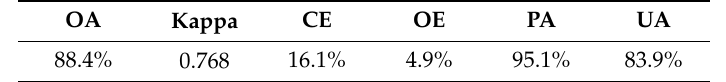
Table 10. The cloud OA, Kappa, CE, OE, PA, and UA of the spectral test of the RTD in Xinjiang.